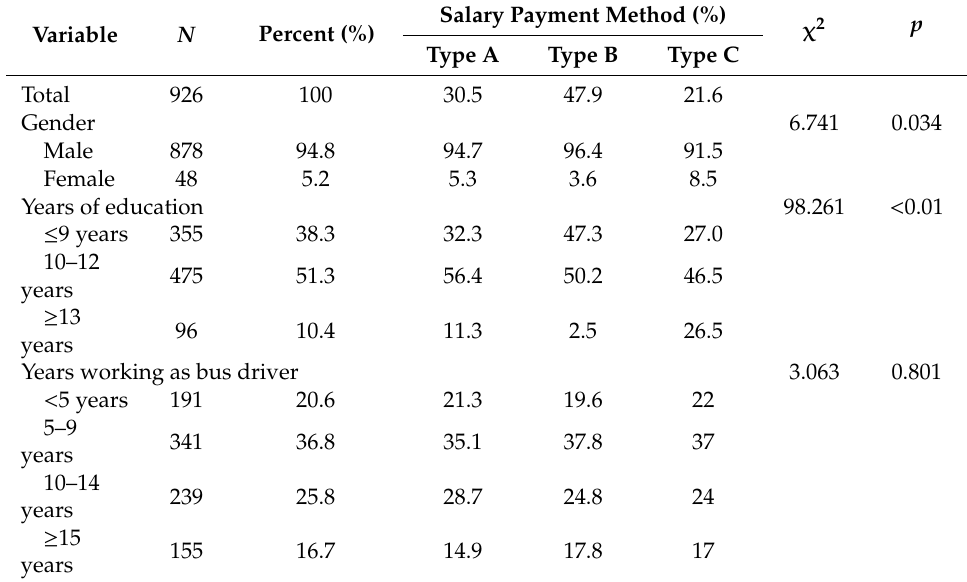
Table 1. Characteristics of surveyed bus